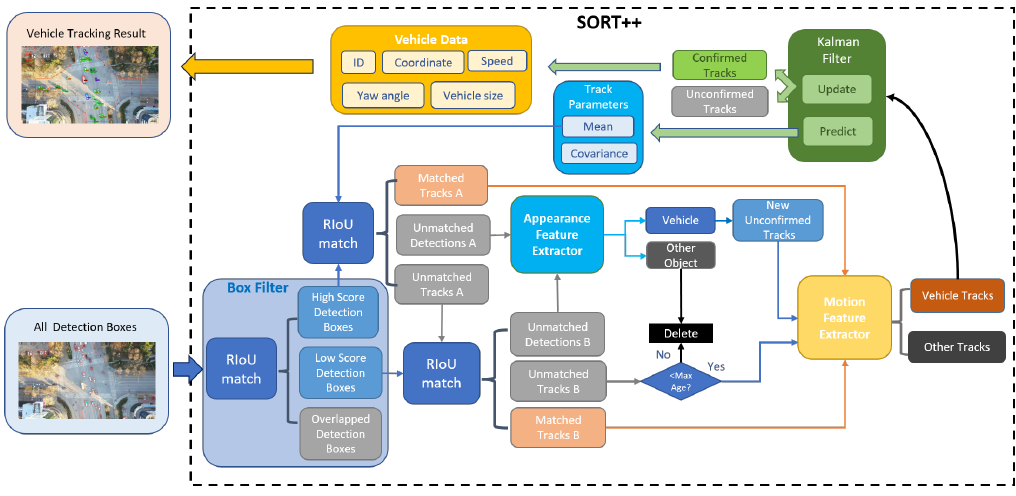
Figure 5. Vehicle tracking process using the SORT++ algorithm.